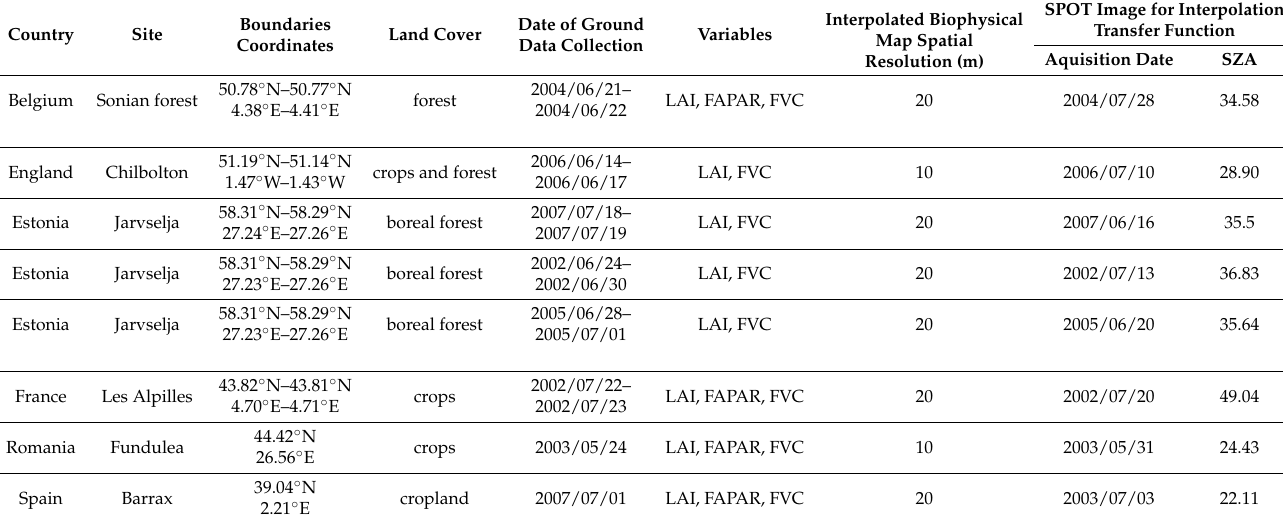
Table A1. Validation campaigns and products offered by the VALERI